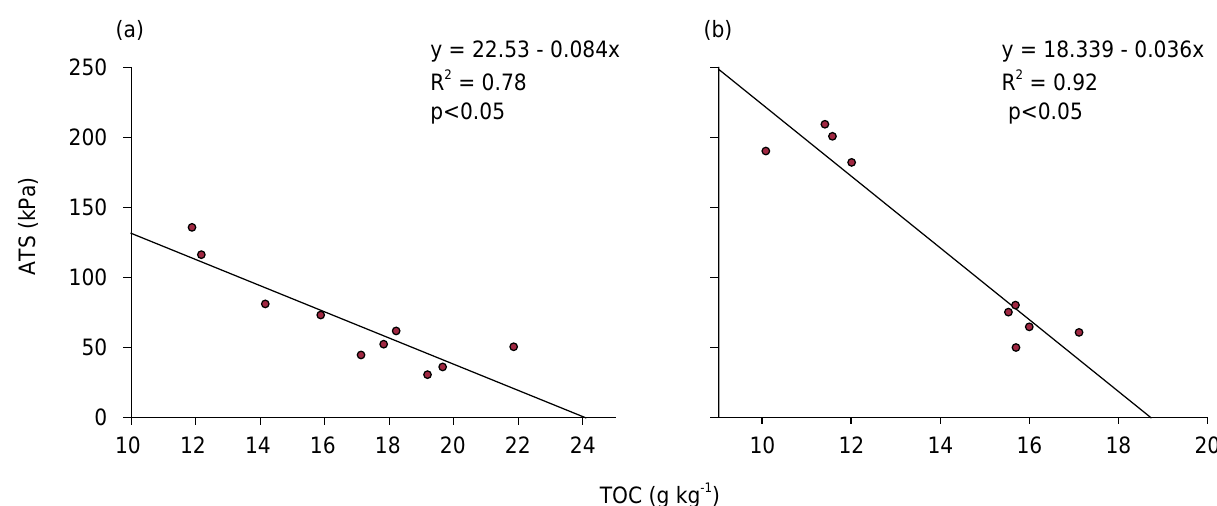
Figure 7. Relation between the aggregate tensile strength (ATS) and total organic carbon content (TOC) of an Albaqualf under different management systems, in the 0.00-0.10 (a) and 0.10-0.20 m (b)